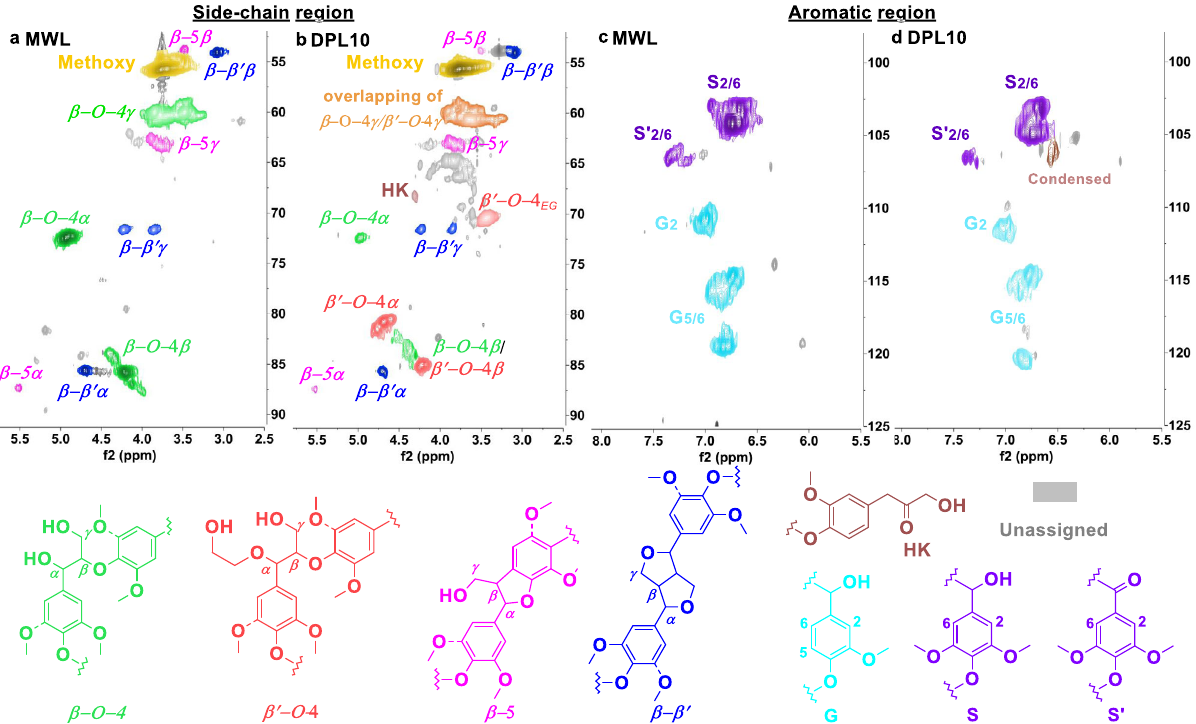
Fig. 6 Comparison of mill wood lignin (MWL) and DPL10 from birch lignocellulose. 1 H – 13 C cross signals in the side-chain region of MWL ( a ) and DPL10 ( b ), showing obvious ethylene glycol incorporation signals of β΄ -O-4 which means stabilization of the benzylic carbocation in β -O-4 by EG (the EG incorporation signals were con fi rmed by overlapping the HSQC NMR spectrum of lignin and model compound) and aromatic region of MWL ( c ) and DPL10 ( d ) with typical S and G signals, slight condensation (14 – 16%) signal was observed in the aromatic region of DPL10. Spectra of both MWL and DPL10 were recorded by dissolving the corresponding lignin in d6-acetone for measurement instead of commonly used d6-dmso (several drops of D 2 O were added when not fully soluble in d6-acetone) 68